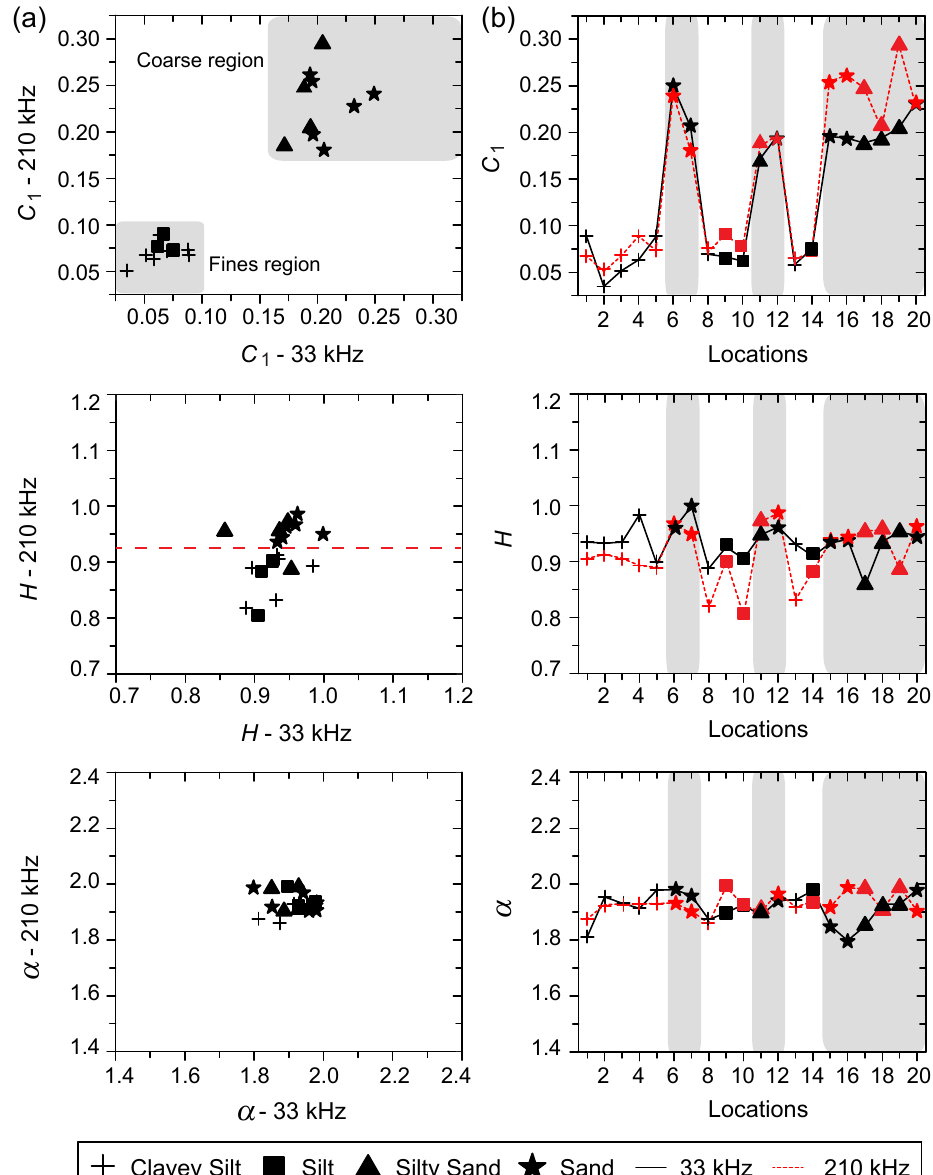
Fig. 7. Panel (a) shows the comparison of the computed multifractal parameters ( α , C 1 , and H) at frequencies 33 and 210kHz. The C 1 values are well clustered, demarcating the coarse and fine sediment provinces. The horizontal dash line (red) demarcates the H values at 210kHz in fine and coarse sediment provinces. The variations in multifractal parameters for different frequencies with the same sediment types at each location are represented in panel (b) , the shaded region corresponds to coarse sediment